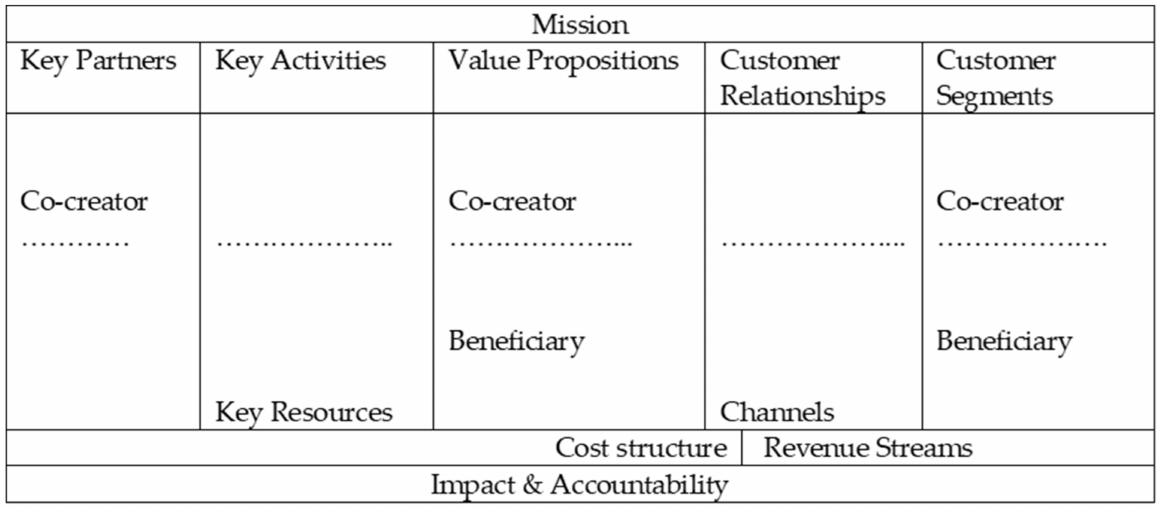
Figure 1. Business Model Canvas for energy enterprise (Source: The authors’ own elaboration based on Qastharin